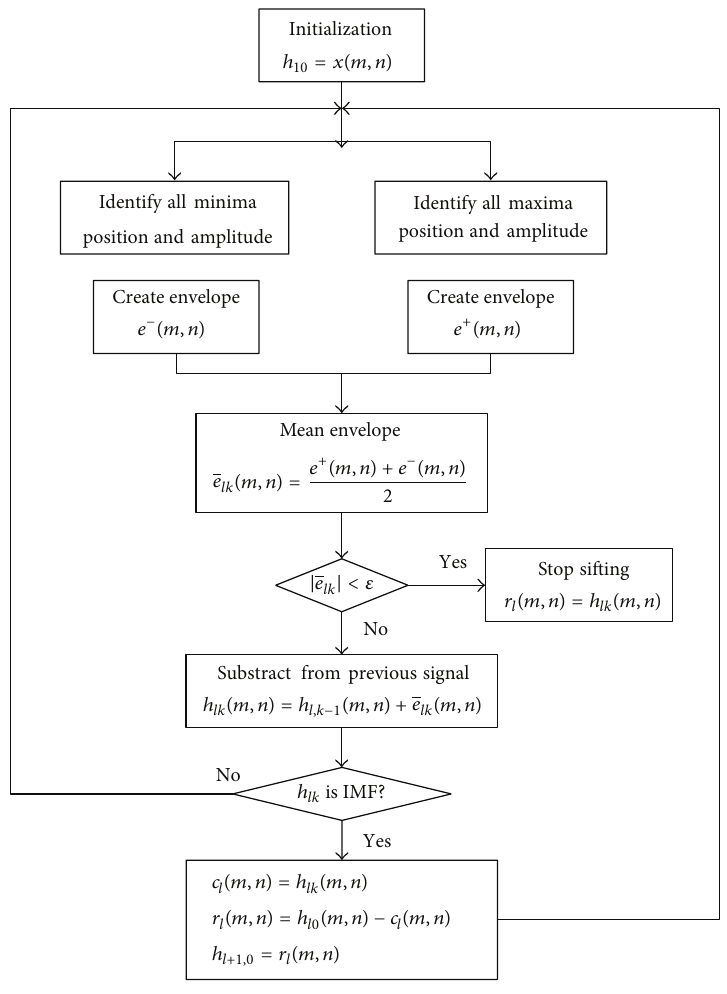
Figure 1: Sifting process of